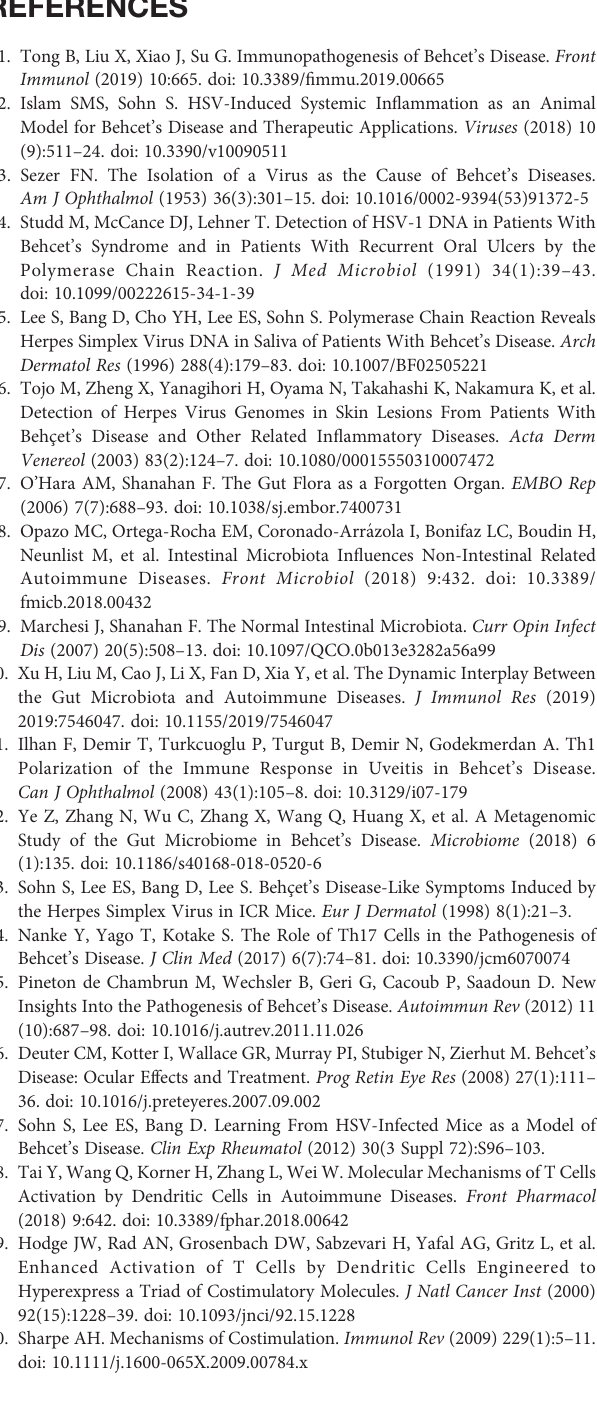
Supplementary Figure 2 | The frequency of regulatory T cells in BD mice treated with colchicine or the combination of colchicine and E. rectale was analyzed by FACS (A – G) . Untreated BD mice were used as the control group. The p-value was determined by the Kruskal-Wallis test. The experiments were performed independently at least three times. Supplementary Figure 3 | The frequency of CD4+, CD8+, CD11b+, and CD11c+ cells in LN of BD mice treated with colchicine or the combination of